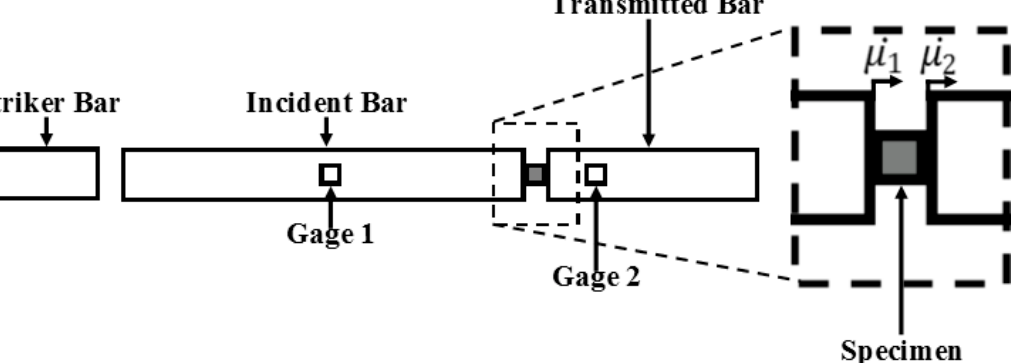
Figure A3. Illustration showing the location for the bars, strain gauges, and specimen in a typical Split-Hopkinson pressure bar (SHPB) configuration. Velocities for the incident and transmitted bars are denoted by 𝑢 1 (cid:4662) and 𝑢 2 (cid:4662) .